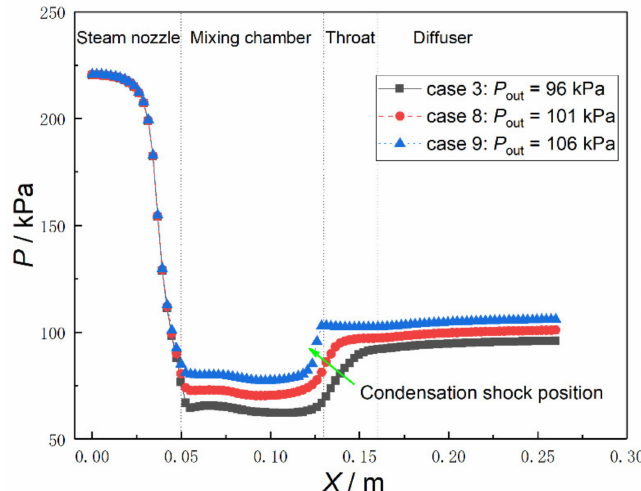
Figure 13. Axial static pressure profiles along the centerline at different